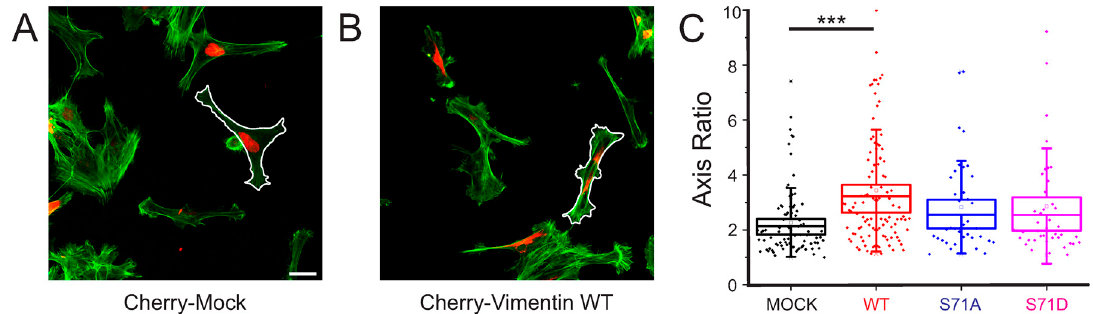
Figure 3. Expression of wild-type but not S71-phospho-mutant vimentin changes the axis ratio of the cells. ( A , B ) Representative images of cells expressing ( A ) Cherry-mock or ( B ) Cherry-vimentin, with regard to F-actin (green) and vimentin or control (red). The thin white lines outline the cell borders, as drawn and used for axis ratio analysis. Scale bars; 35 µm; ( C ) Quantification of the axis ratio of cells under the different conditions, as indicated. The boxes correspond to the standard error of the mean, and the whiskers to the standard deviation. *** p < 0.001 (Student’s t -test).